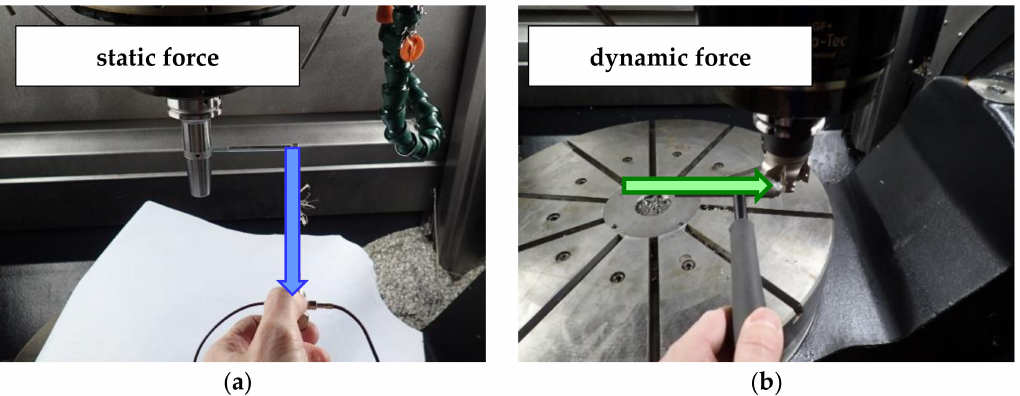
Figure 1. Demonstration of two possible calibration procedures: ( a ) calibration with static force; ( b ) calibration with dynamic